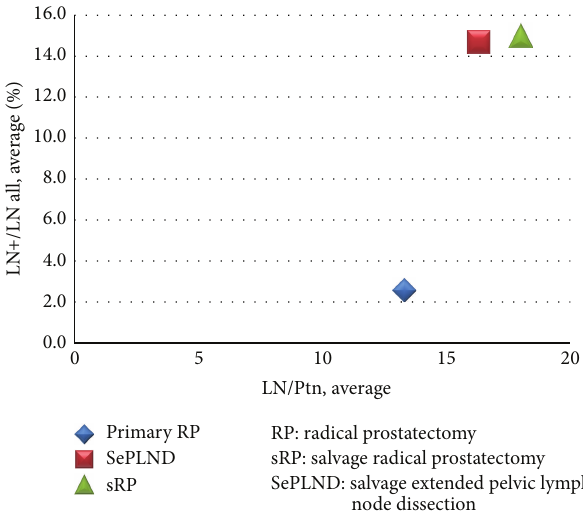
Figure3:CorrelationbetweennumberofremovedLNsandnumber of